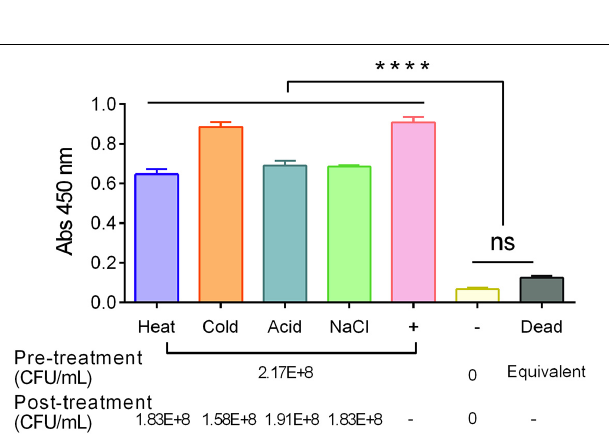
FIGURE 3 | Detection of stress-exposed S. Enteritidis PT21 using MaCIA. Bacteria were exposed to heat (45 ◦ C), cold (4 ◦ C), acidic pH (4.5) and NaCl (5.5%) for 3 h before analysis. +, Positive control (bacteria without any stress exposure); –, No bacteria; dead, heat-killed S . Enteritidis cells. Error bars represent SEM. **** P < 0.0001; ns, no significance.